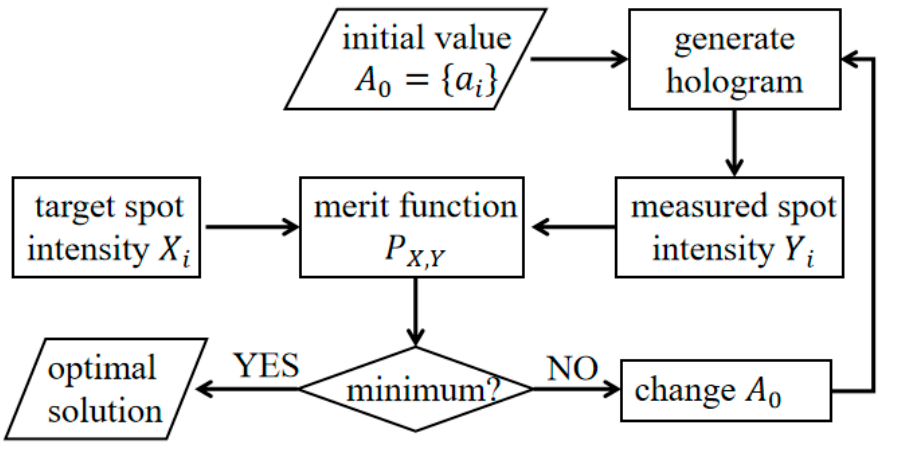
Figure 3. Flow chart of the optimization process.